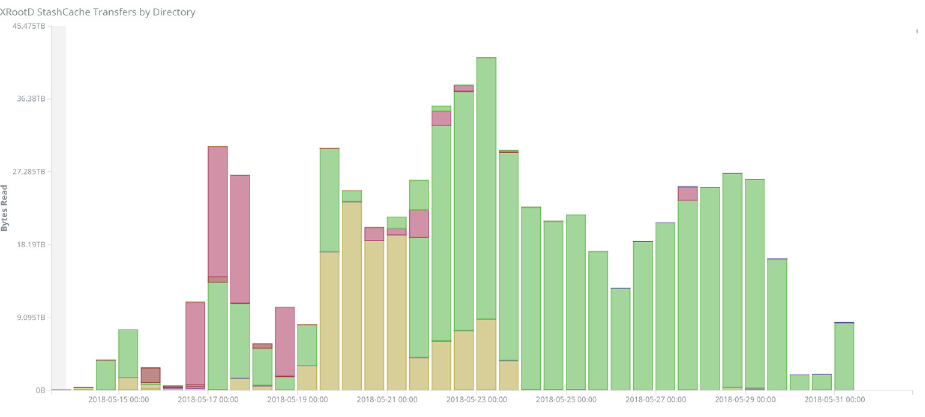
Figure 1. GRACC Overview